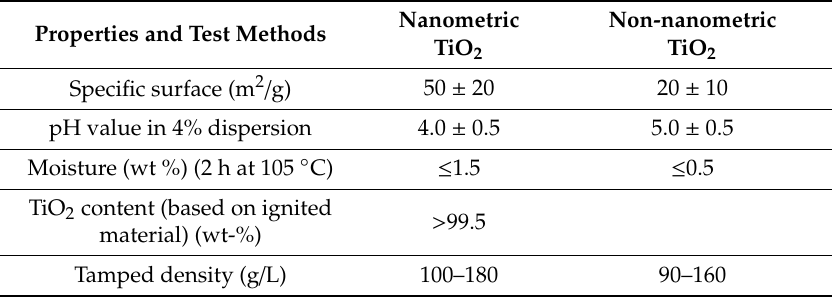
Table 1. Chemical-physical characteristics of the TiO 2 samples used in the